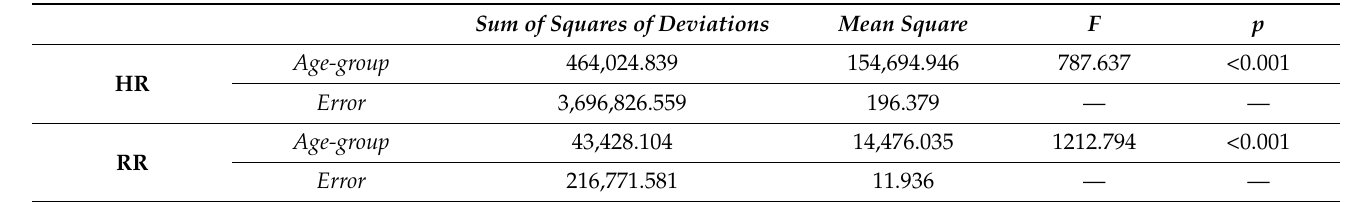
Table 7. Results of repeated analysis of variance measures on HRs and RRs. Sum of Squares of Deviations